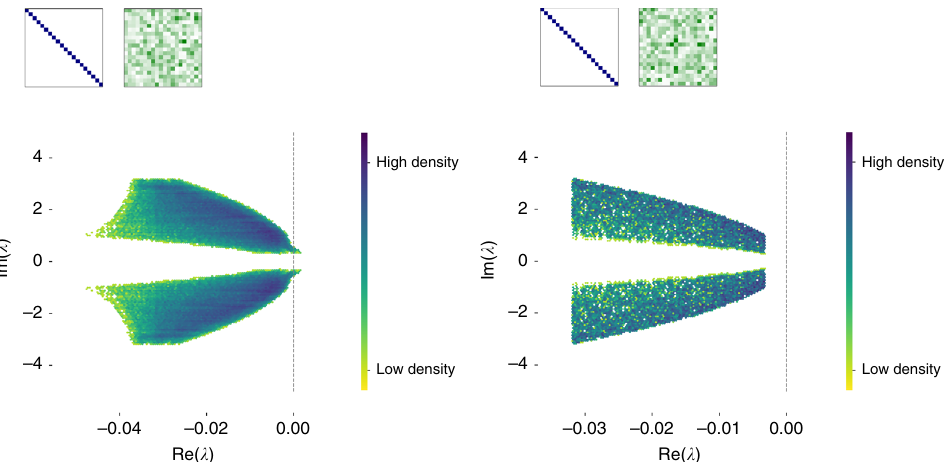
Fig. 3 Positive equilibria are guaranteed to be stable if exchange of resources is reciprocal. We show two examples demonstrating feasible solutions of (5). Plots show the density (colored from red to blue) of eigenvalues for the Jacobian matrix at this equilibrium, de fi ned using a fi xed, diagonal matrix of consumer preferences. This is shown inset in blue, where each row represents a distinct resource and each column represents a distinct consumer; blue squares indicates a nonzero rate of consumption. We also consider a fi xed, more general matrix of production rates (inset in green). Again, each row represents a distinct resource, each column represents a distinct consumer, and darker green indicates a higher rate of production. Each plot is obtained over multiple random draws for consumer and resource densities s and r , de fi ned in the main text, and drawn from a uniform distribution (subject to the constraints necessary to ensure that these densities can be obtained with positive in fl ux and mortality rates ρ and μ ). In the left-hand panel, we consider a random set of production rates, which does not satisfy the bound necessary to guarantee stability, and indeed we see that there are some positive eigenvalues of the Jacobian matrix, to the right of the black dashed line. In the right-hand panel, we show a similar case but where we impose that the production matrix P is symmetric, meaning that each consumer gets as much of its favored resource as it gives. Even though the production matrix looks ‘ similar ’ to the naked eye in each case, this symmetry in the latter example is enough to guarantee local stability, with the largest eigenvalue bounded away from zero by a gap related to the consumer